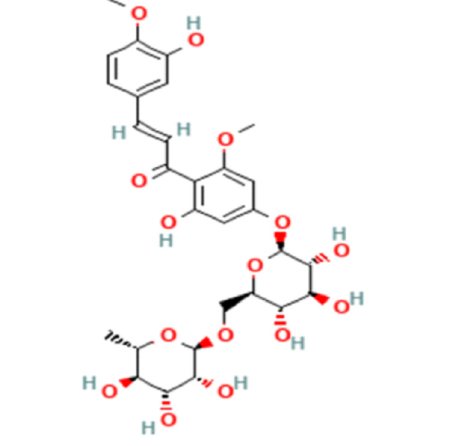
Figure 1. Chemical structure of HMC (compound CID: 6436550; https://pubchem.ncbi.nlm.nih.gov, accessed on 7 April 2022).